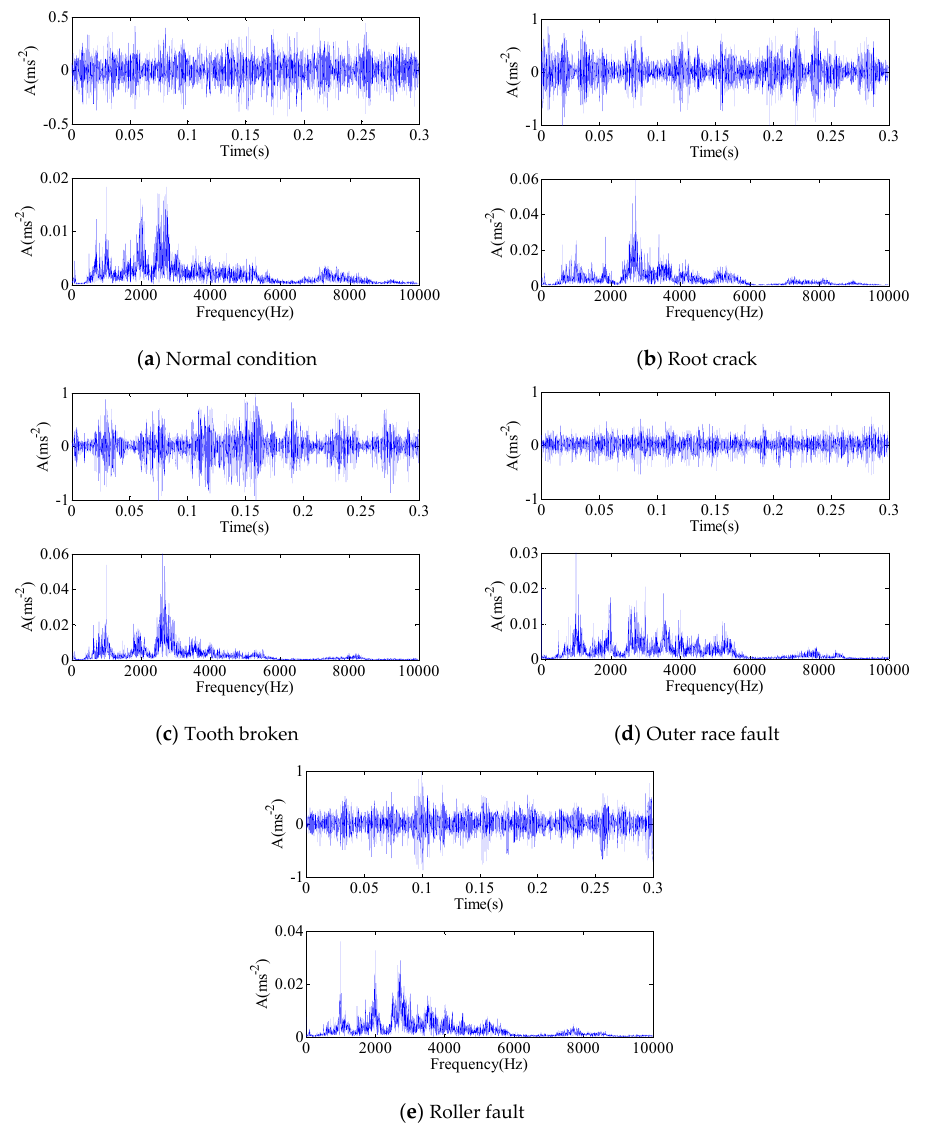
Figure 14. The time waveforms and frequency spectra of vibration signals: ( a ) Normal condition; ( b ) Root crack; ( c ) Tooth broken; ( d ) Outer race fault; ( e ) Roller fault.